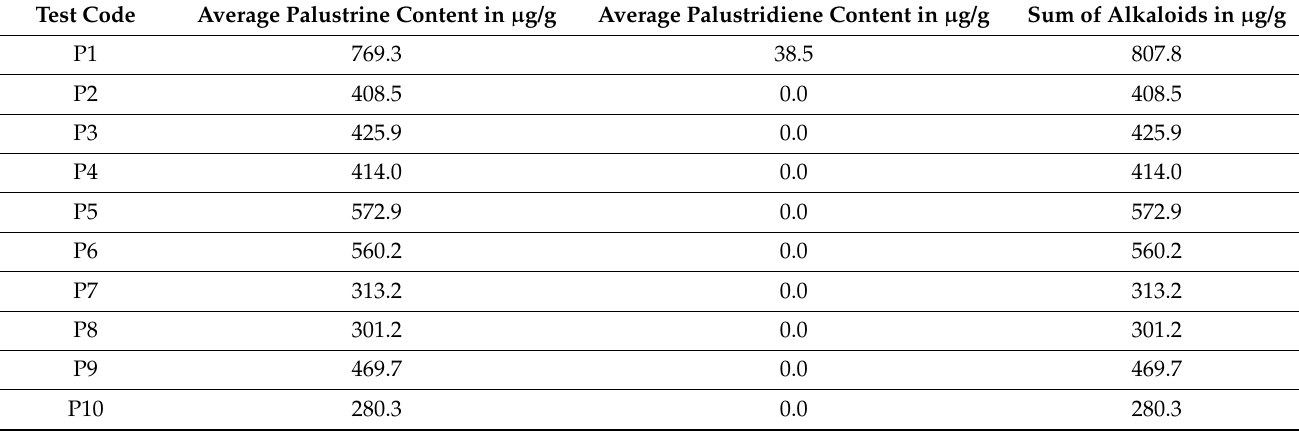
Table 2. The Equisetum alkaloid content of the E. palustre samples analyzed by LC-MSMS. Values of 0.0 indicate results below the